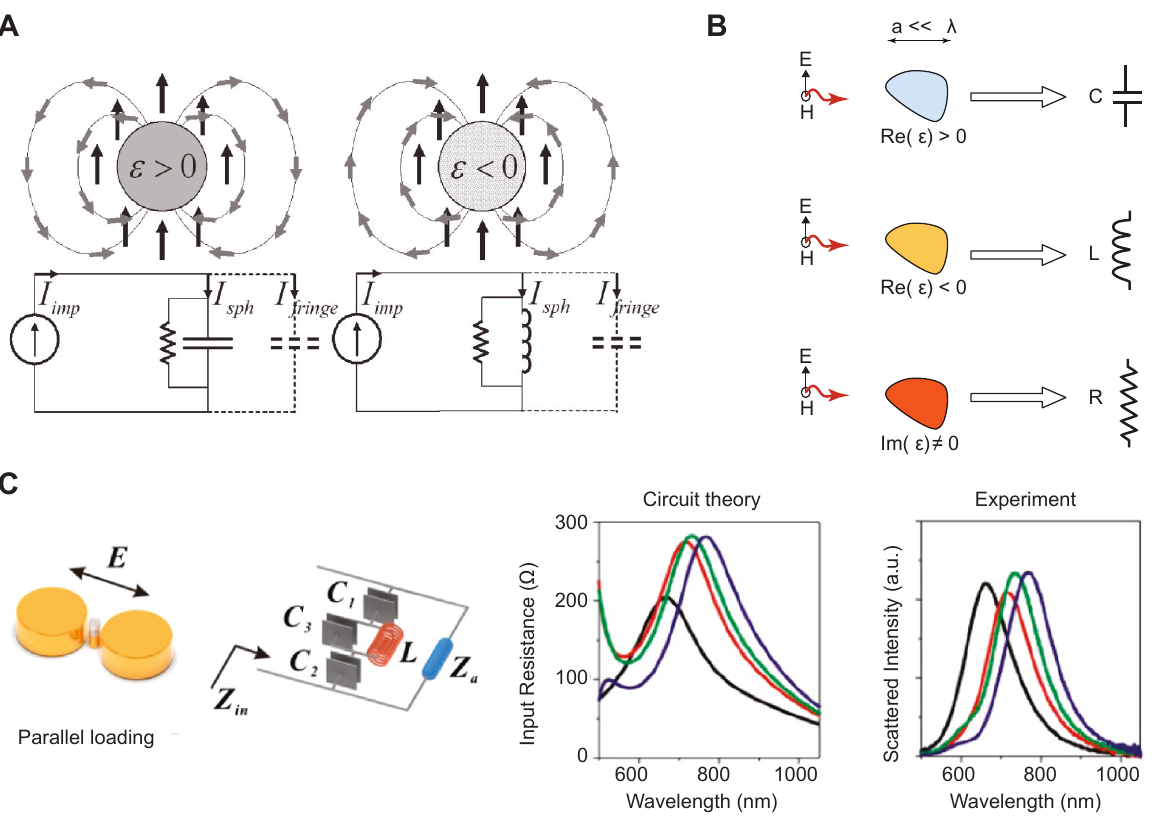
Figure 5: Optical nanocircuits: (A) The concept of optical nanocircuit theory in the optical domain. Adapted from the study by Engheta et al. [137]; (B) Lumped optical circuit element equivalents of materials with different dielectric permittivities. Nanocapacitor (top), nanoinductor (middle),andnanoresistor (bottom)areshown.Adaptedfromthestudy byEngheta[136];(C)Schematicshowingtheequivalentopticalcircuit modelofaloadedPNA( fi rstandsecondpanels).Thefar- fi eldscatteringspectrumofthePNAobtainedwiththeopticalnanocircuitmodel(third panel) is in remarkable agreement with the experimental measurements (fourth panel). Adapted from the study by Liu et al. [147]. PNA, plasmonic